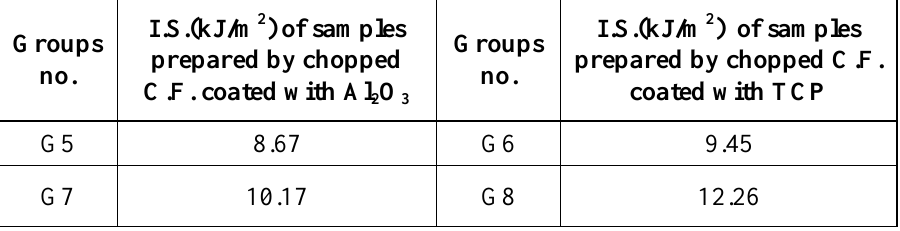
Table 3: Result of impact strength for samples with different fibers